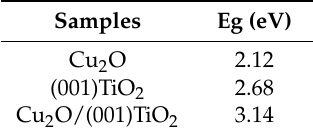
Figure 6. ( a ) UV-vis Light Diffuse Reflectance spectra of the catalysts; ( b ) DRS spectra of the samples; ( c ) Band gap calculation from DRS spectra by Kubelka–Munk method of the materials. Table 1. The band gap energy values of the different samples.